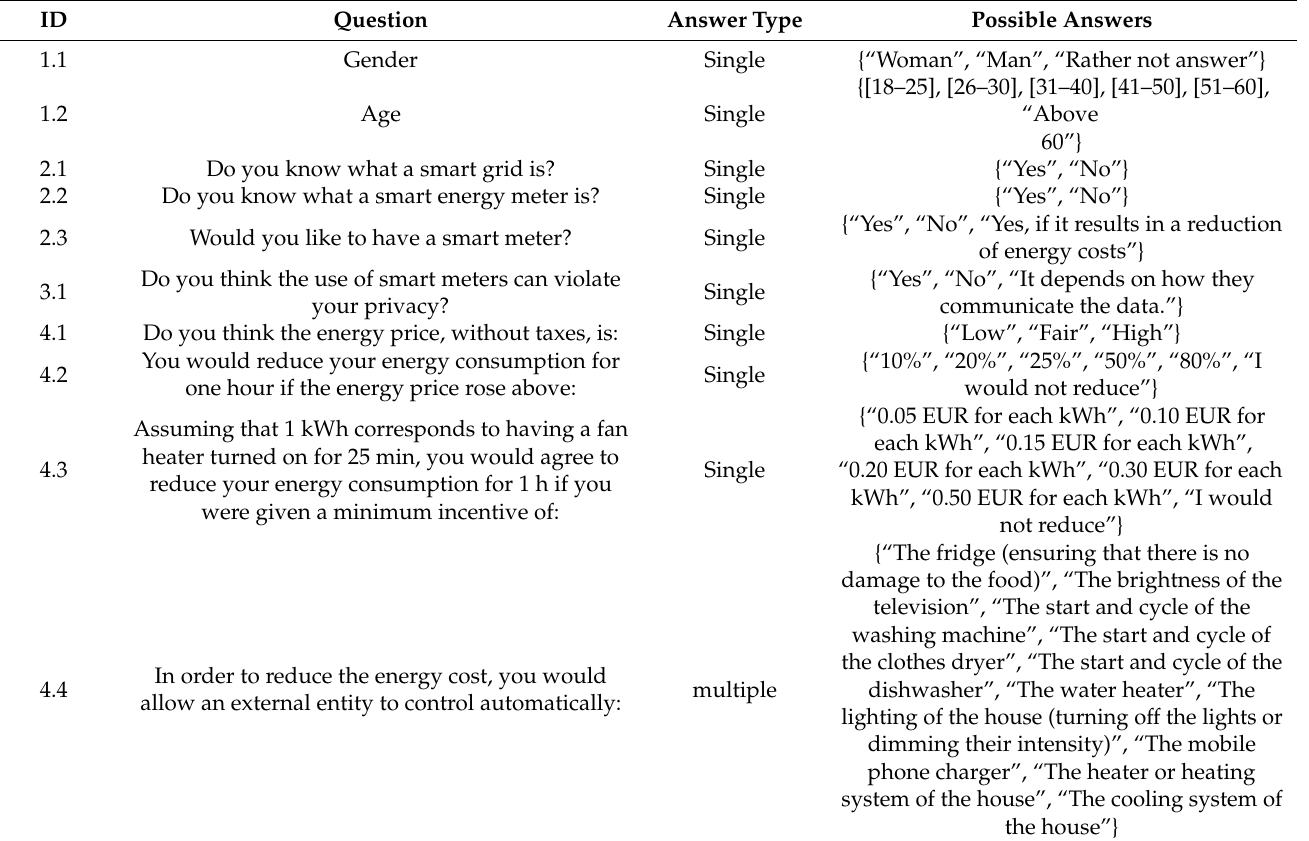
Table 1. Questions included in the